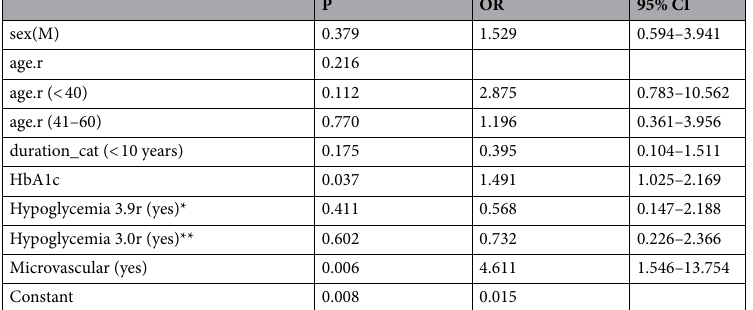
Table 2. Predictors of high diabetes-related distress (total PAID score ≥ 40). *Patients with at least one symptomatic hypoglycemia with blood glucose ≤ 3.9 mmol/L within the last 3 months. **Patients with at least one symptomatic hypoglycemia with blood glucose ≤ 3.0 mmol/L within the last 3